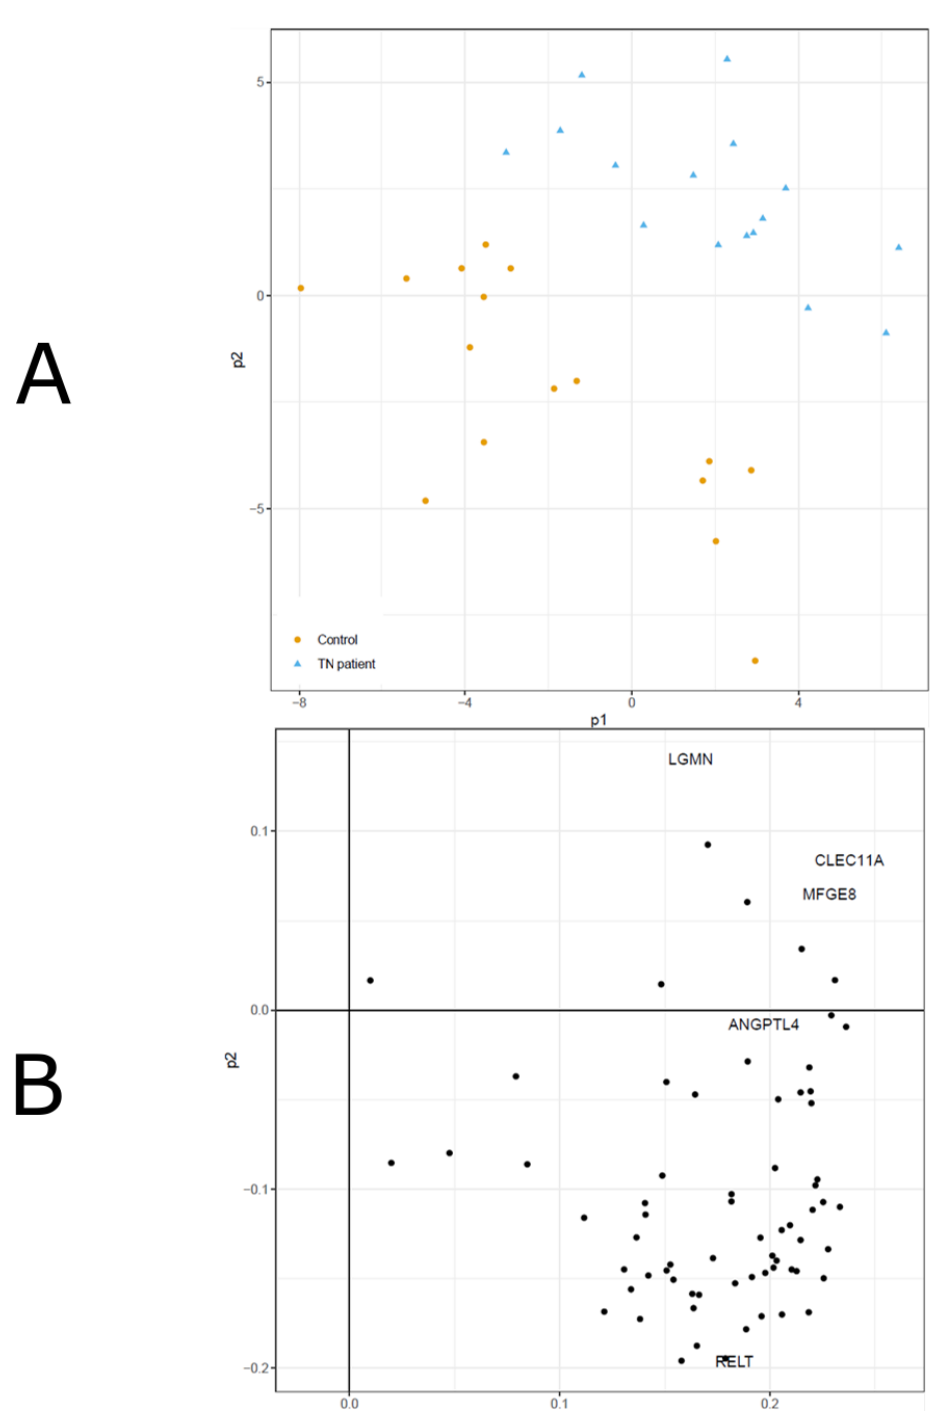
Figure 2. ( A , B ). CSF biomarkers in TN patients and controls—a PLS-DA analysis. A PLS-DA model (2A) and the corresponding loadings (2B) of CSF biomarkers in TN patients and controls are demonstrated. The model was trained to separate between TN and controls. The model showed good performance (mean error rate = 0.058) in separating between the two groups as evaluated in the cross-validation procedure. In the loadings plot, all proteins with VIP > 1.3 are named, and the remaining proteins are only shown as dots.